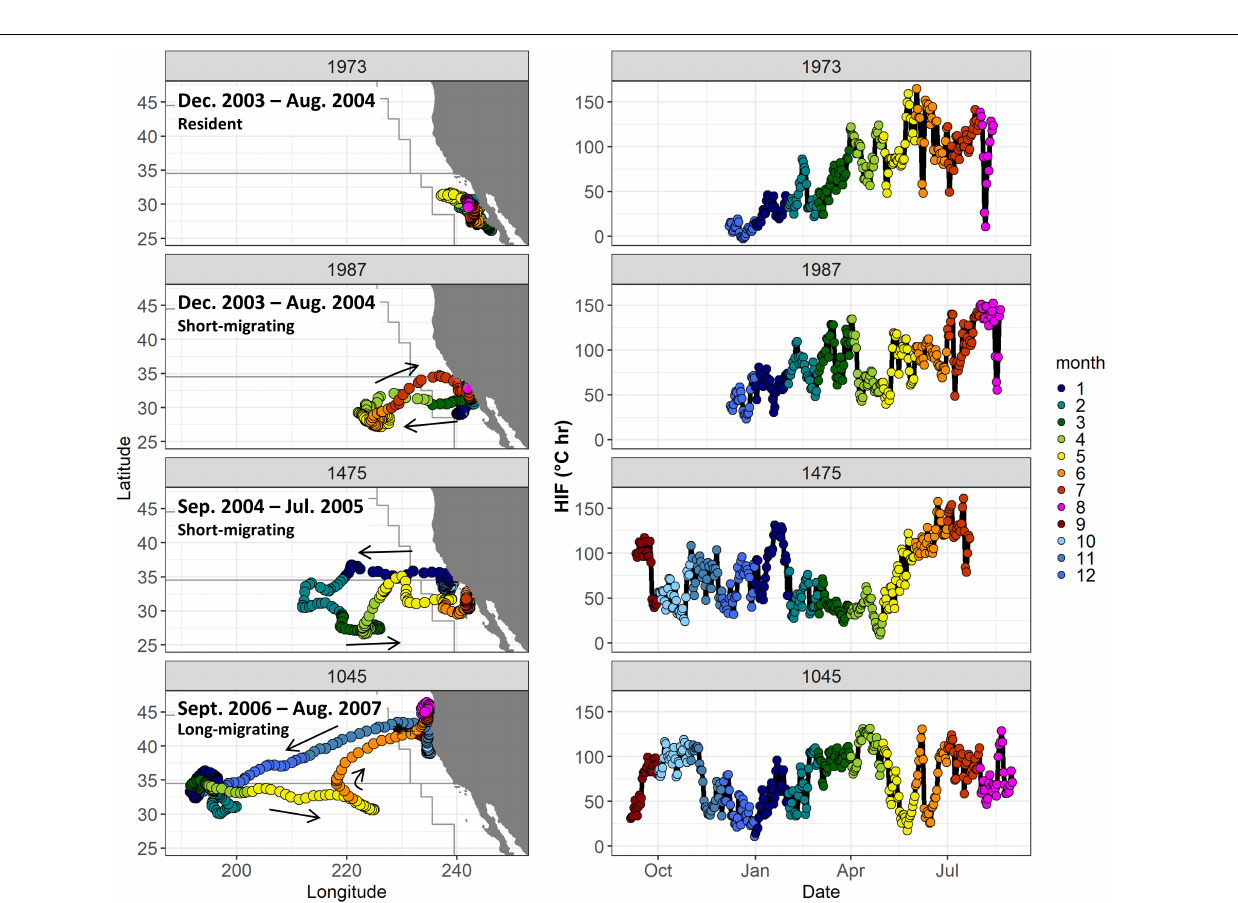
FIGURE 4 | Daily locations (left) , and daily mean HIF (right) for four example fish showing different migration patterns (see Table 1 ). Colors denote month, arrows show migration directions. Boundaries of modified Longhurst regions from Figure 1 are also shown.